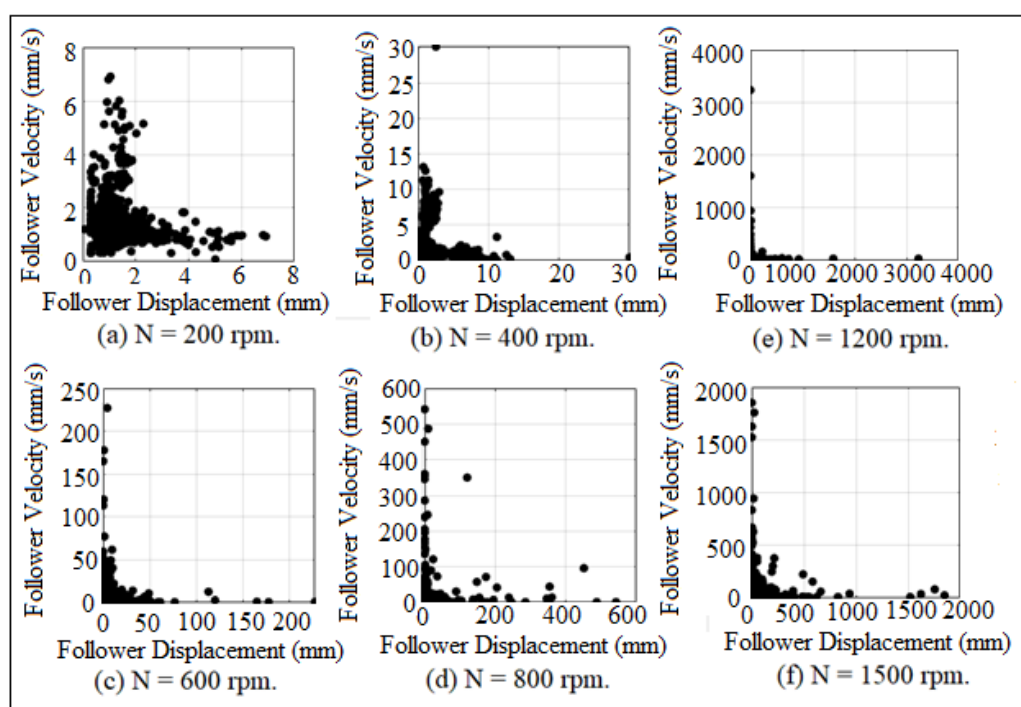
Figure 41. Poincare’ maps for (I.D. = 17 mm) at different cam speeds.